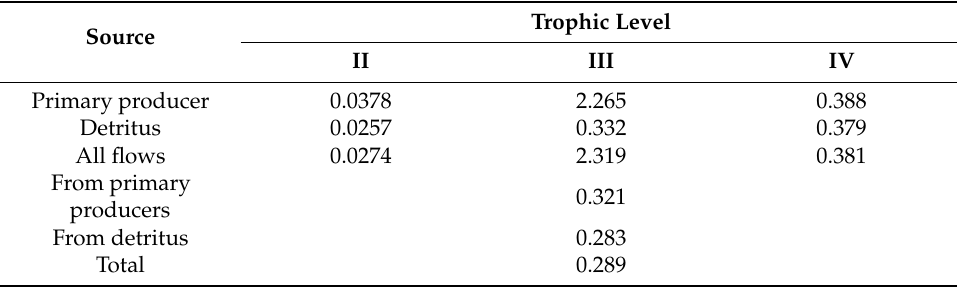
Table 4. Transfer e ffi ciency (TE) of each trophic level of the Lake Datong ecosystem